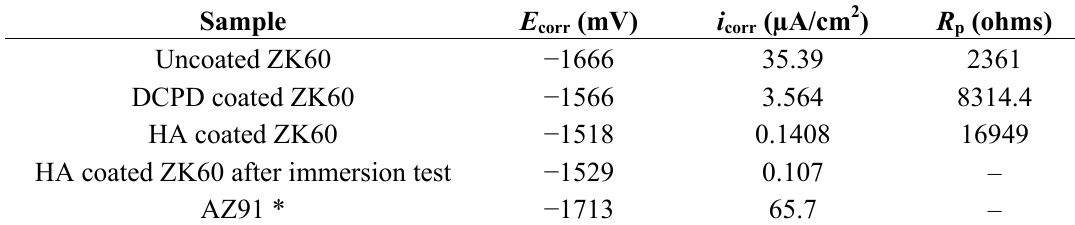
Table 1. Electrochemical data extracted from the polarization curves and Nyquist curves.